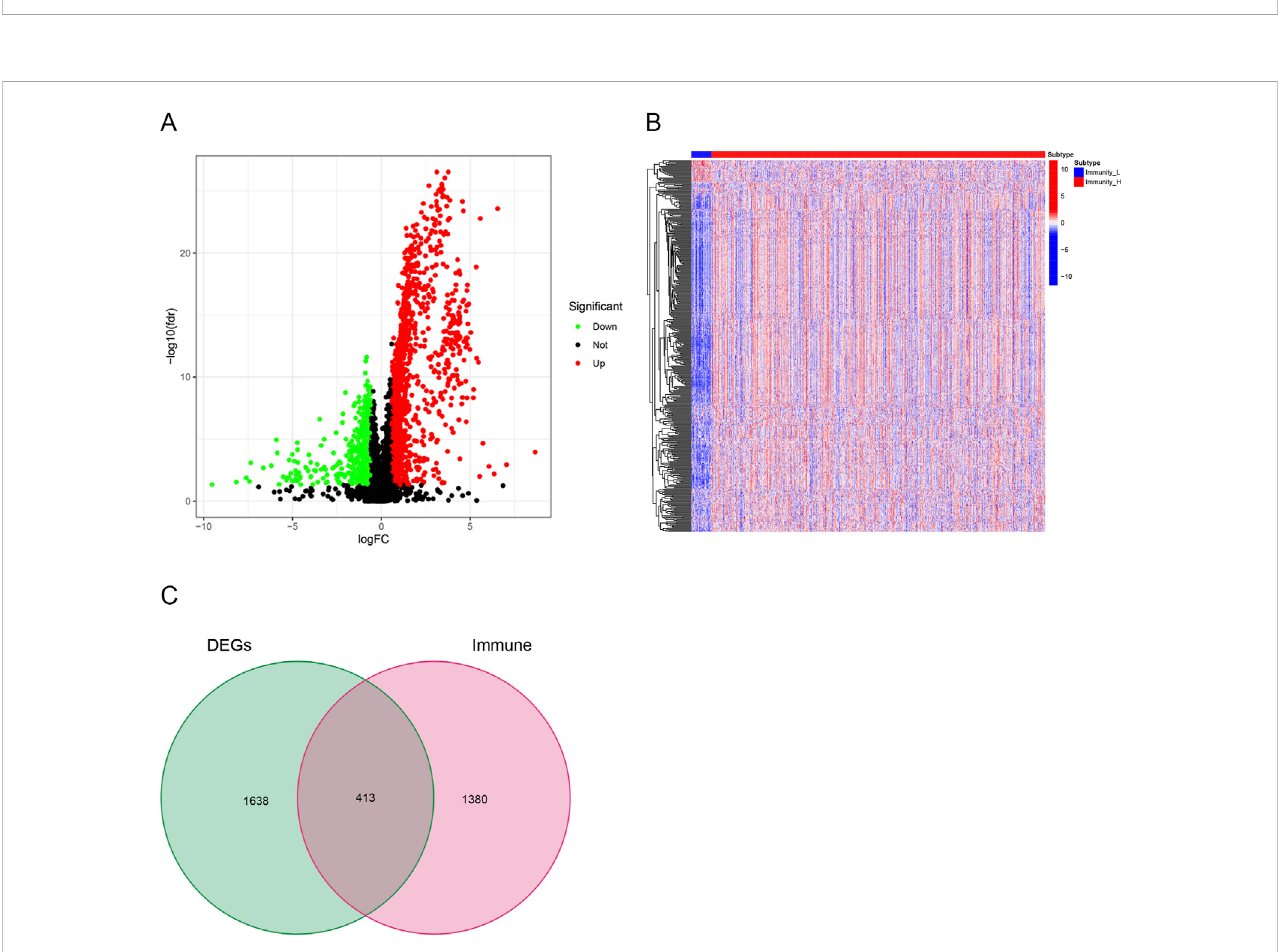
FIGURE 4 Identi fi cation of differentially expressed immune-related genes. (A) Volcano plots showing 845 downregulated genes (green) and 1,206 upregulated genes (red) in the cluster with high immune cell in fi ltration. (B) Heatmaps showing 27 downregulated immune-related genes (blue) and 386 upregulated immune-related genes (red) in the cluster with high immune cell in fi ltration. (C) Venn diagram showing the intersection of differentially expressed genes (DEGs) and immune-related genes. In all, 413 overlapped genes were identi fi